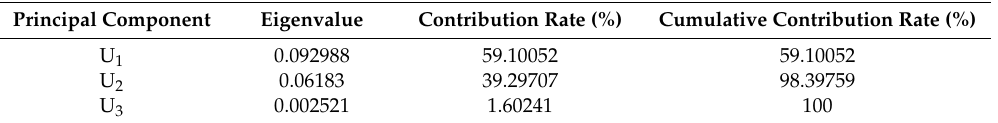
Table 2. Index eigenvalue and contribution rate.